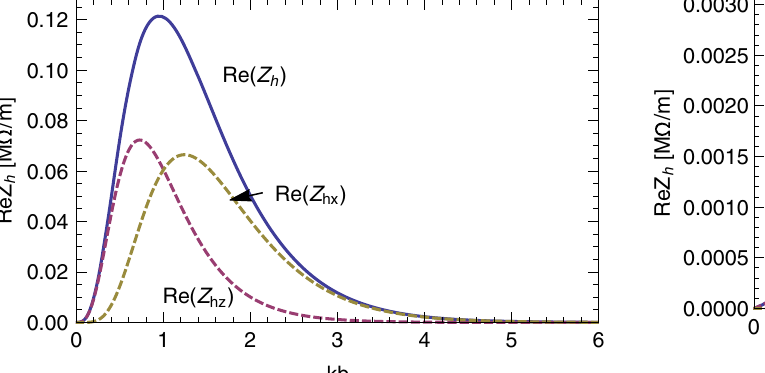
Þ ¼ h Þ [Re ð Z Þ ] hz hx